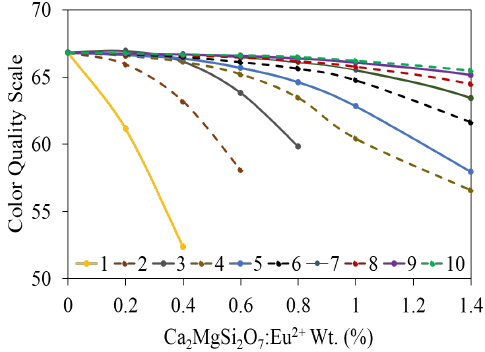
Fig. 4: The color quality scale of WLEDs as a function of the size and concentration of Ca 2 MgSi 2 O 7 :Eu 2+